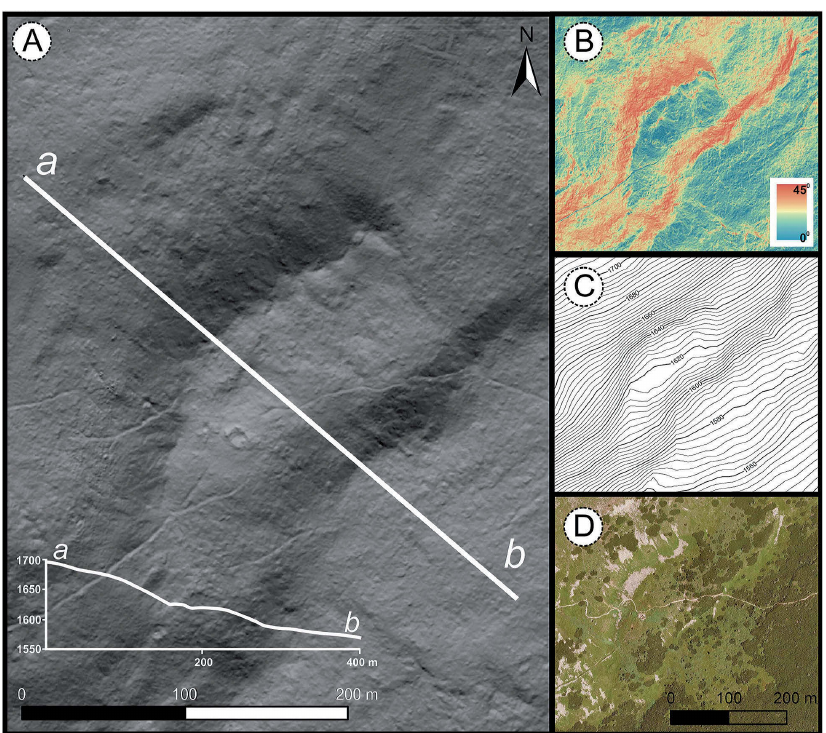
Fig. 4. Test area No 3. A – LiDAR image (a–b – topographic profile and its location), B – the map of slope reductions generat- ed from LiDAR (range of slope reductions is given), C – contour-line map, D – orthophotomap. Maps B–D at the same scale, Map A at larger scale